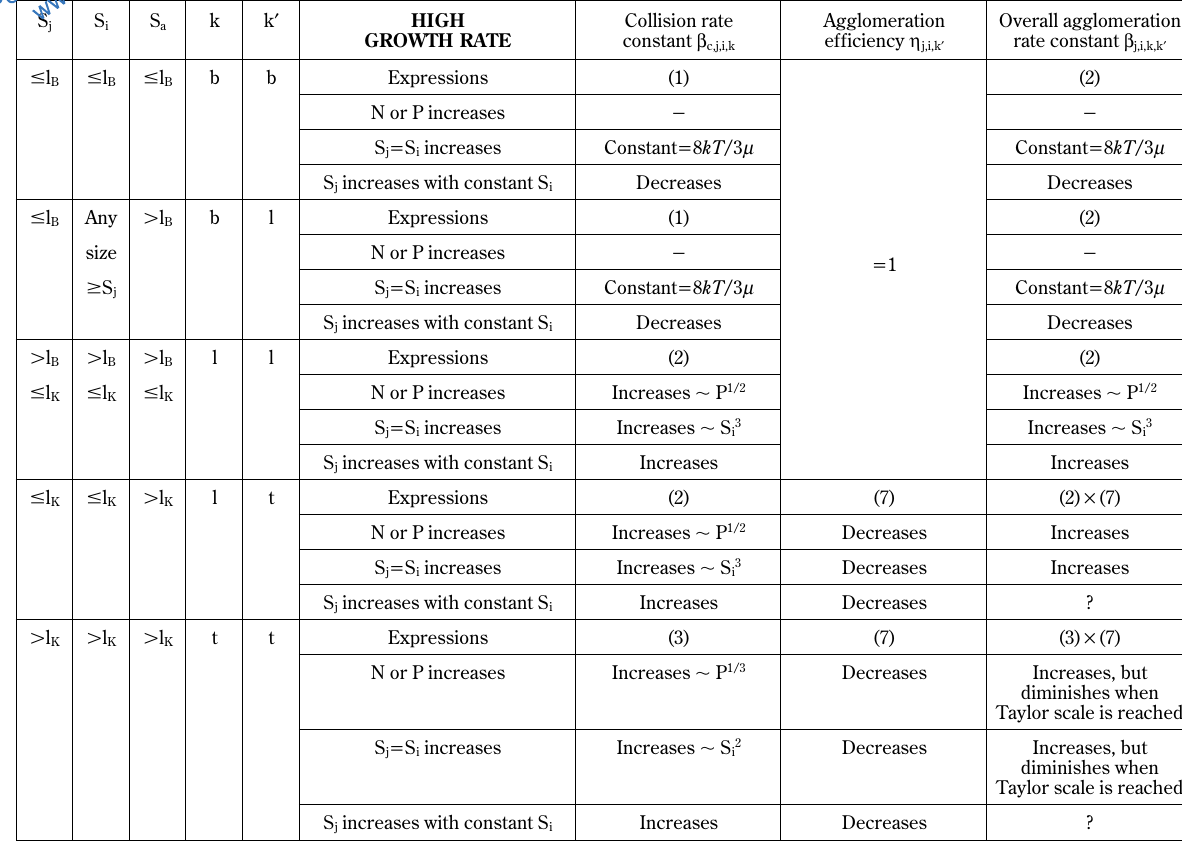
The relations numbered (1)-(7) correspond to those of Table 1 .